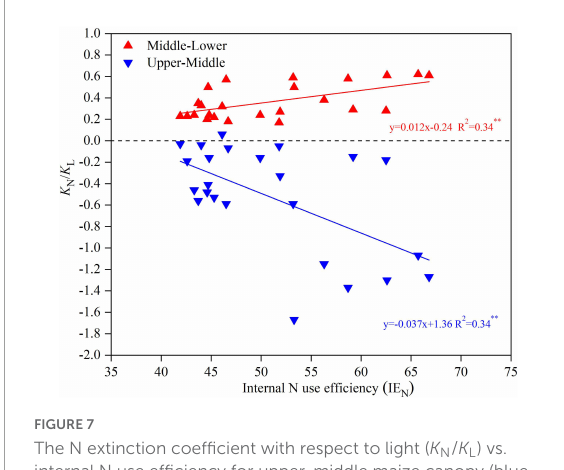
FIGURE7 The N extinction coefficient with respect to light ( K N / K L ) vs. internal N use efficiency for upper-middle maize canopy (blue line) and middle-lower maize canopy (red line) in 2019 and 2020.